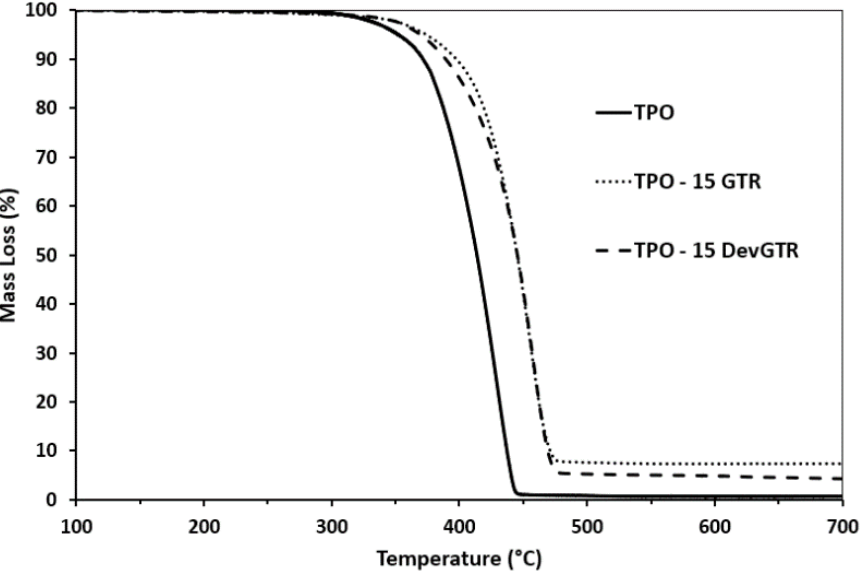
Figure 7. TGA thermograms of TPO, TPO-GTR, and TPO-DevGTR materials (under N 2 , 10 °C/min).